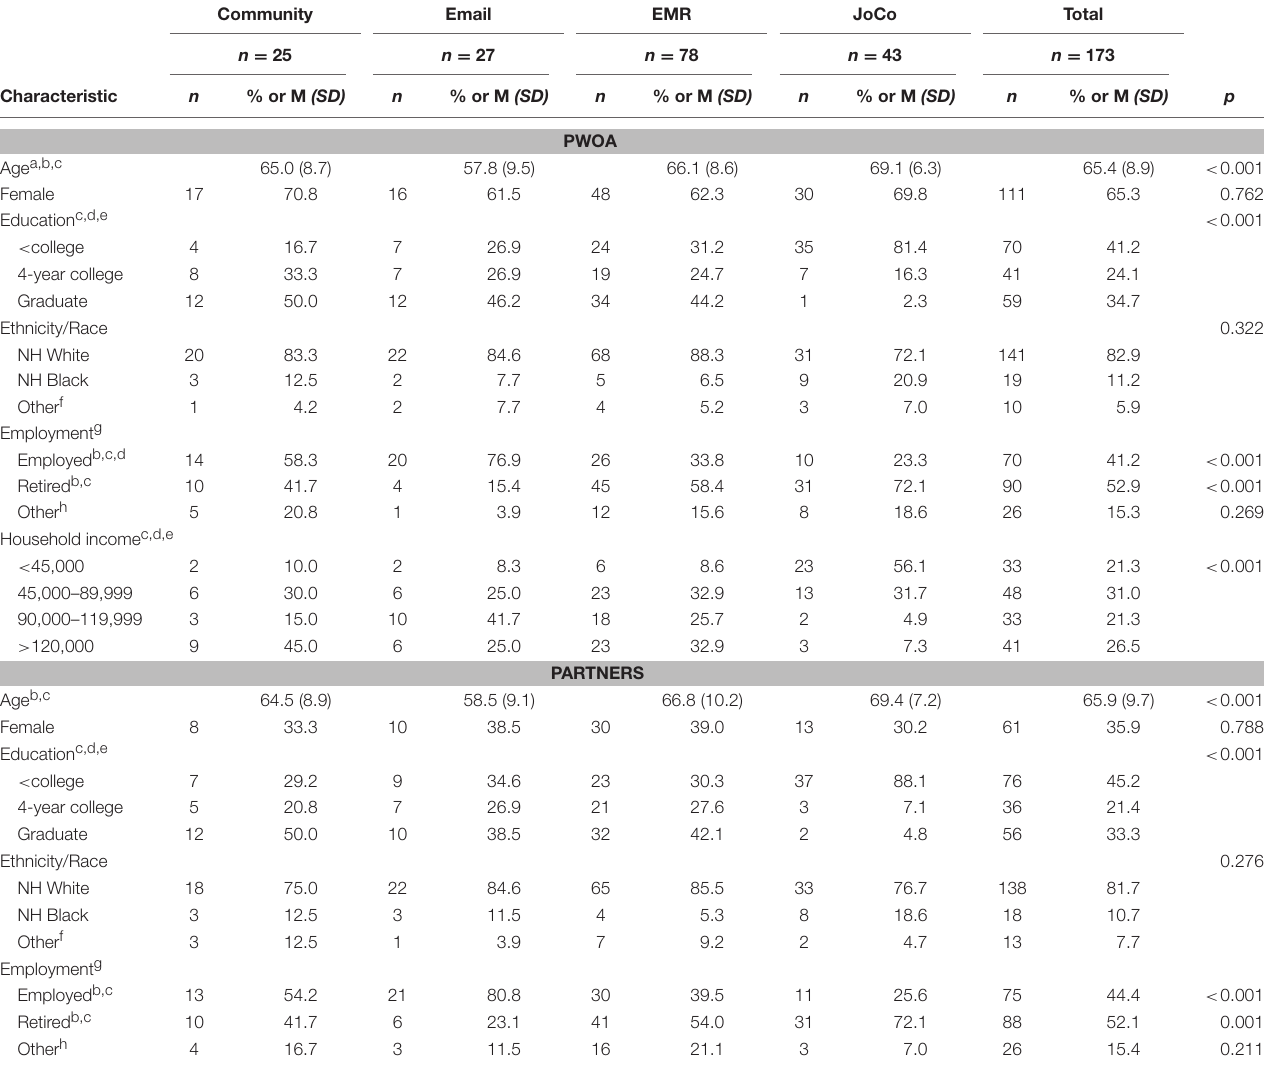
TABLE 2 | Demographic characteristics of PWOA and partner participants by recruitment method.